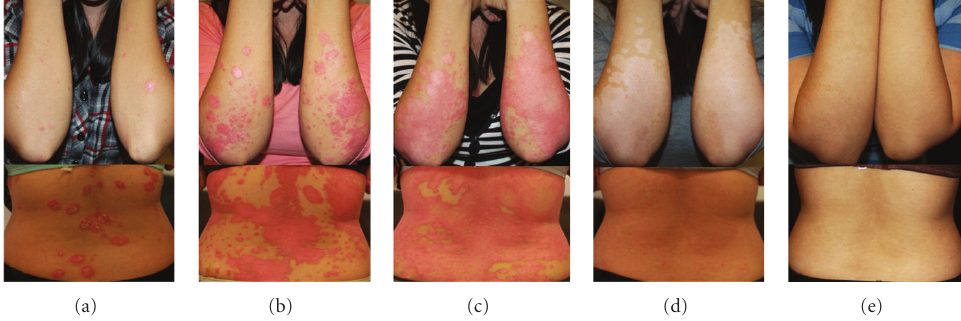
Figure 5: Progression of psoriasis improvement in patients with prior non-immunosuppressants therapy. Photographs taken before treatment, sharply marginated erythematous papule with a silvery-white scale (a). Existing psoriatic plaques developed and spread in sizes at month 1 (b). Flakes exfoliated from psoriatic lesion reduced in size, existing psoriatic plaques ceased further growth, and psoriatic plaques became thinner at month 2 (c). Existing psoriatic plaques eradicated and subsided lesion areas became paler than normal skin in color, similar to that in vitiligo. Notable improvement of PASI75 was achieved at month 3 (d). Skin areas with the vitiligo coloration took on a natural skin tone, and full clearance was received at month 5